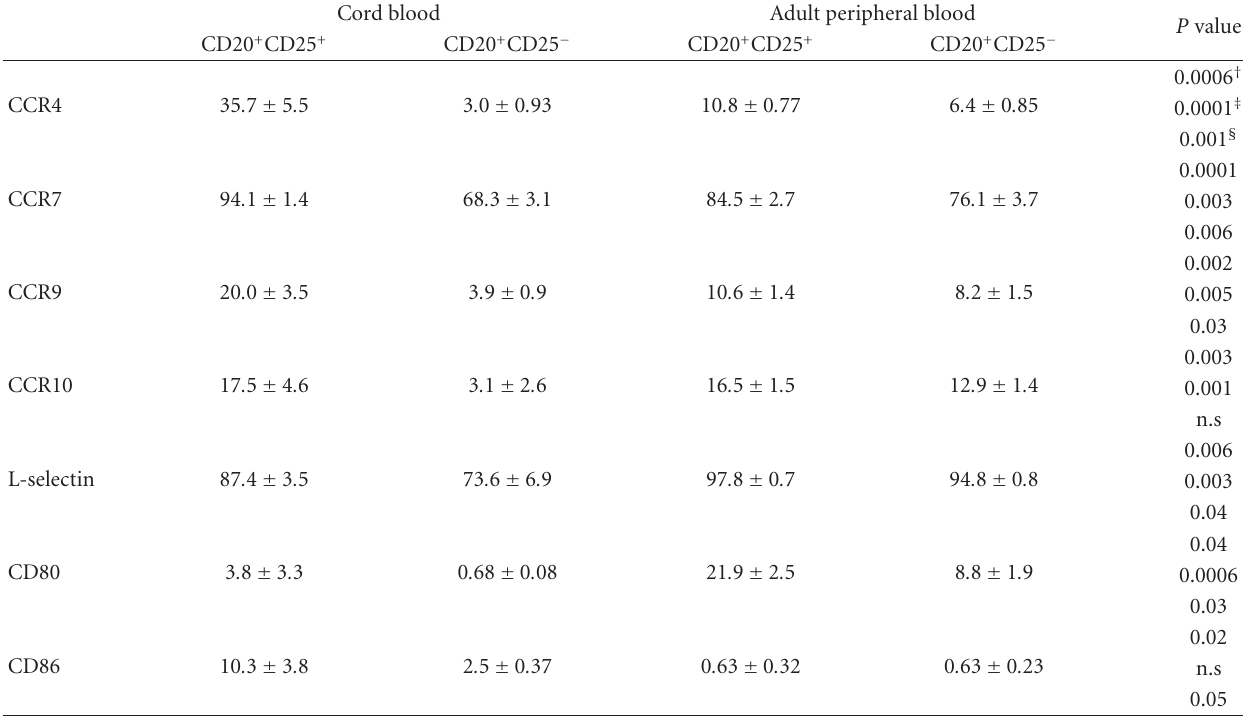
Table 1: Comparison of homing receptor and activation marker expression between CD20 + CD25 + or CD20 + CD25 − cells isolated from human cord blood or from adult peripheral